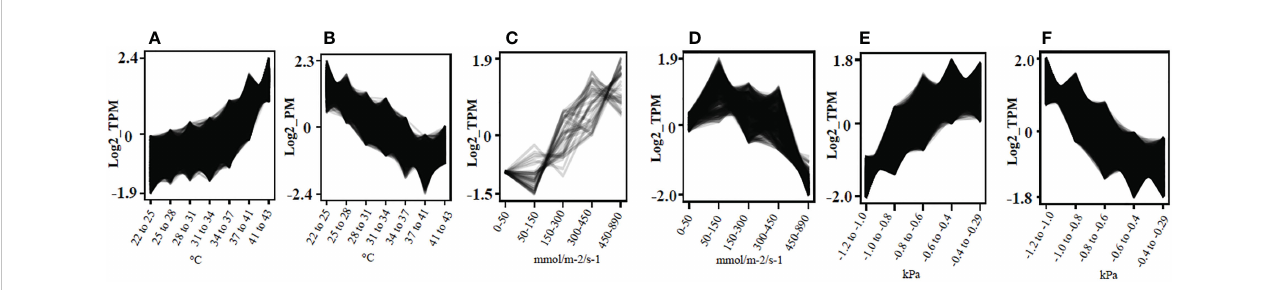
FIGURE 2 Identi fi cation of co-expressed genes in response to leaf temperature, stomatal conductance to water vapor, and stem water potential in grapevine. Gene expression clusters were identi fi ed based on physiological and transcriptome data generated from 94 plants using clust v1.8.4. (A) Gene cluster showing positive correlation with temperature (°C) of non-fully expanded leaves, n = 3,513; (B) Gene cluster showing negative correlation with temperature (°C) of non-fully expanded leaves, n = 1,918; (C) gene cluster showing positive correlation with g s (mmol/m -2 /s -1 ), n = 36; (D) Gene cluster showing negative correlation with g s (mmol/m -2 /s -1 ), n = 401; (E) Gene cluster showing positive correlation with Stem Y (kPa), n = 3,824; (F) Gene cluster showing negative correlation with Stem Y (kPa), n =